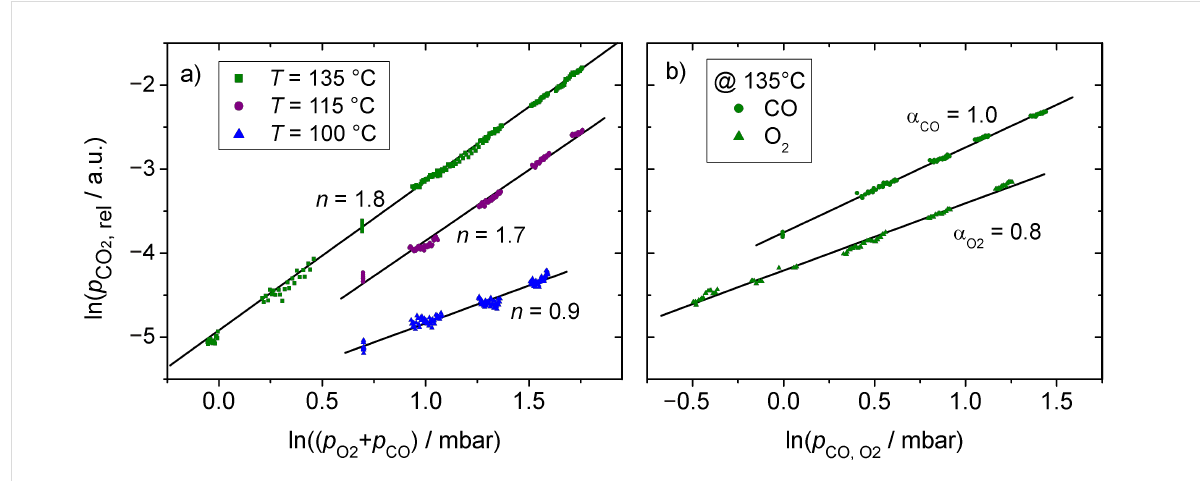
Figure 10: a) Determination of the total reaction order n in the CO oxidation reaction at temperatures of 100 °C, 115 °C and 135 °C by varying the total pressure from 0.5 to 5 mbar at constant reaction gas composition (CO:O 2 = 1:1). b) Partial reaction orders of O 2 and CO at a reaction tempera- ture of 135 °C and constant partial pressure of the other reactant (1